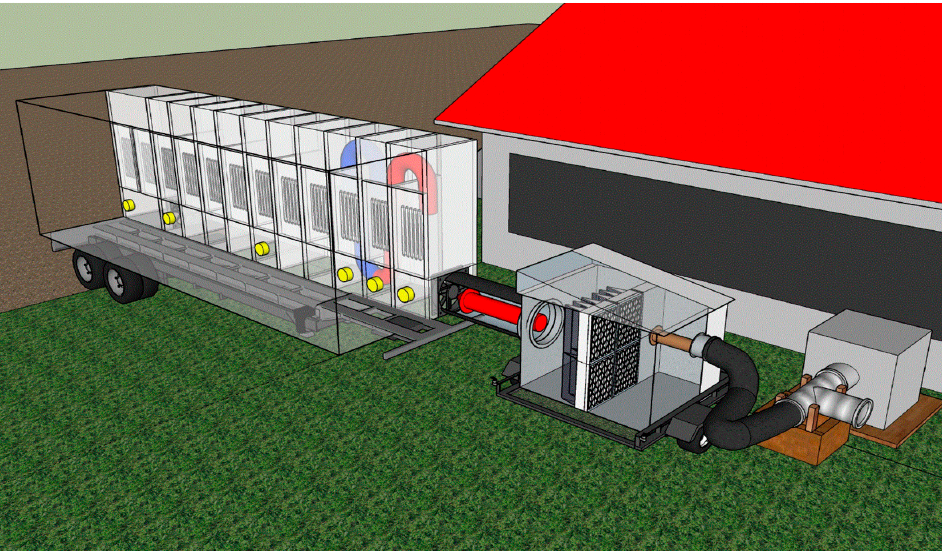
Figure 1. Schematic of a flow-through UV mobile laboratory with filtration unit connected to the continuous fan exhausting gas from stored manure headspace in the pit under barn’s slatted floor. The UV mobile lab consists of a series of connected chambers, each equipped with UV lamps (shown as panels of 5 in each chamber) and sprayed-on photocatalyst on surfaces (coated on all sides of the chamber except for the side installed UV). The lab treated up to 0.78 m 3 ·s − 1 of air. Excess airflow from the fan is discharged to the atmosphere. Cone-tipped ‘pipes’ signify free airflow inflow and outflow. Brown: exhaust air from swine barn; red: inlet air with reduced particle matter load; blue: UV-treated air. Yellow: gas sampling ports.